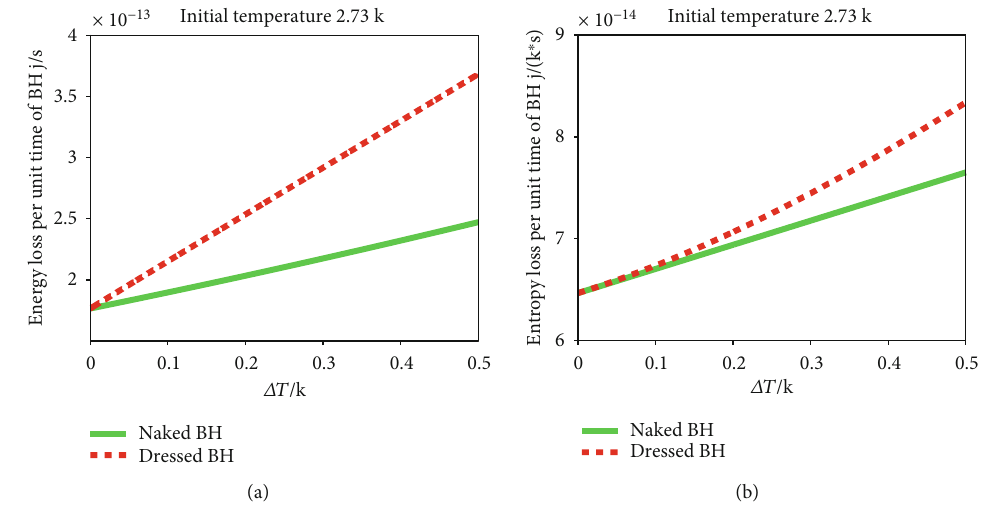
Figure 6: (a) and (b) The energy and entropy loss per unit time of “ naked ” black hole and “ dressed ” black hole varying with the temperature di ff erence with an initial temperature 2.73k. Here, Δ T = T